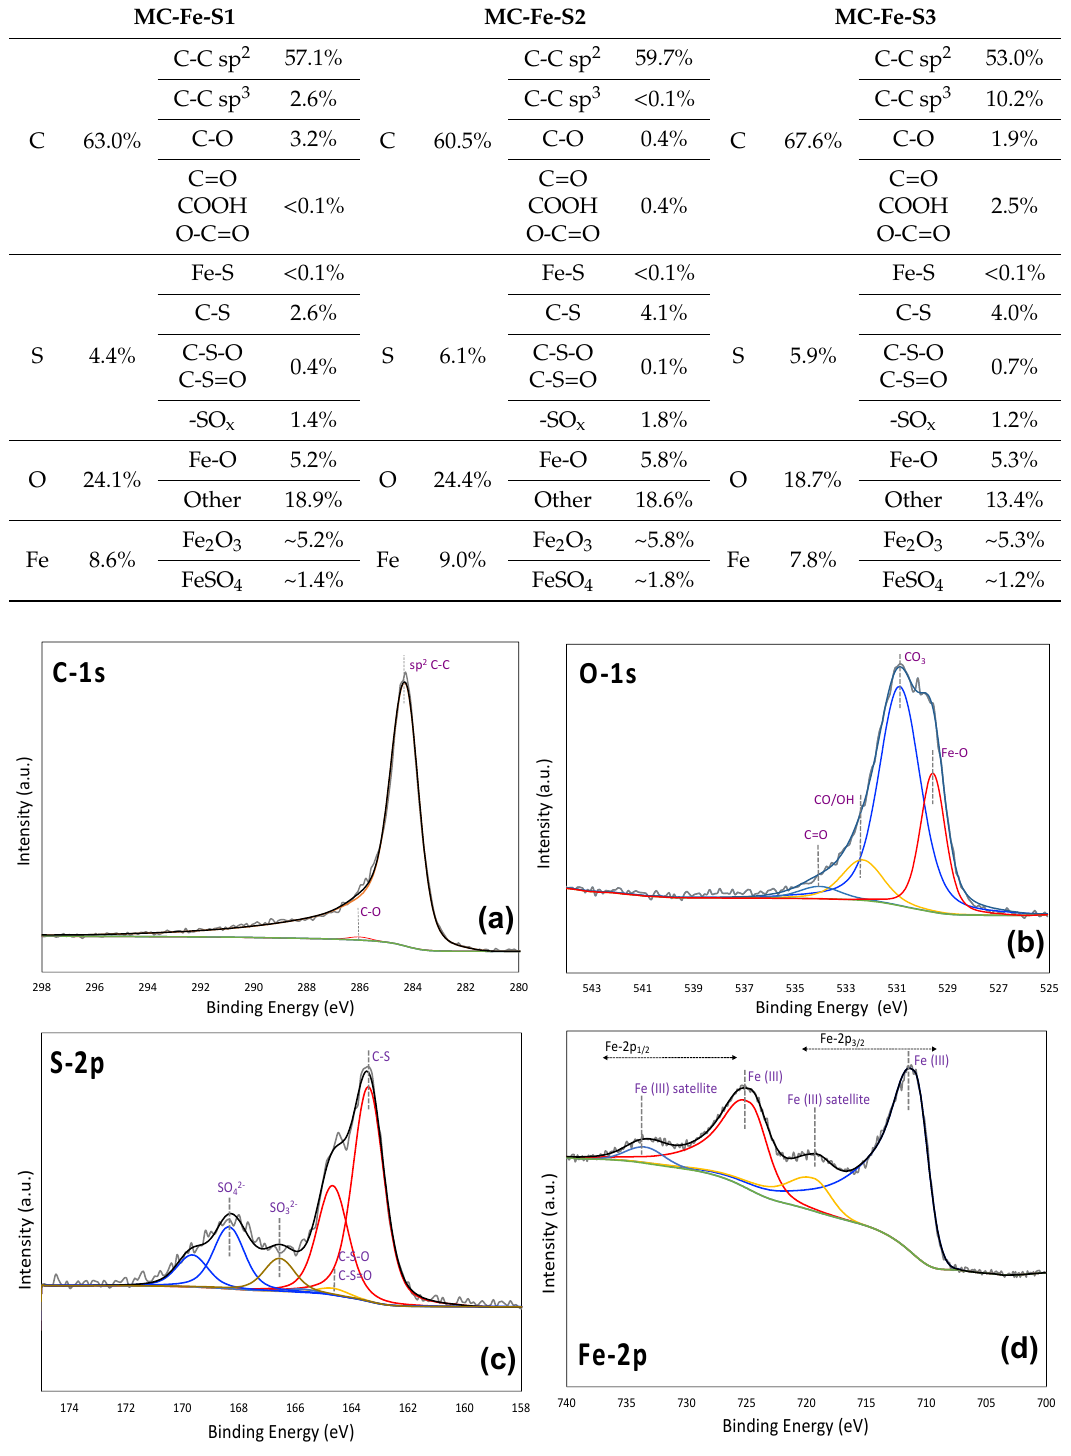
Figure 3. Representative XPS peak fitting of C-1s ( a ), O-1s ( b ), S-2p ( c ) and Fe-2p ( d ) spectra for MC-Fe-S2.